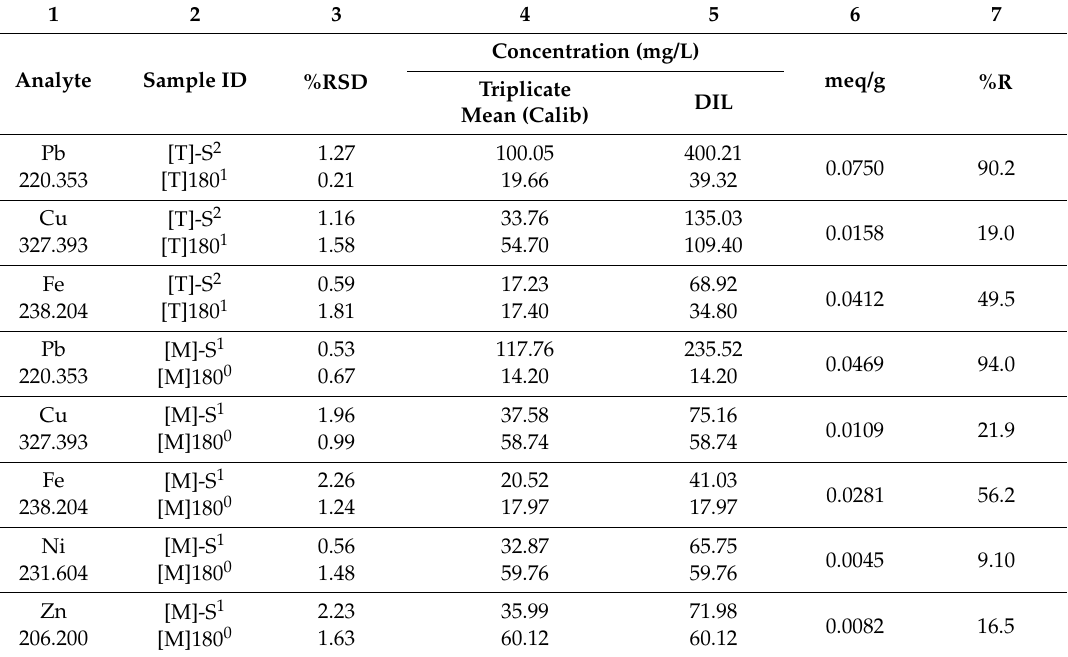
Table 3. ICP-AES HMI results of the triple- and multi-component systems. Table 3. ICP ‐ AES HMI results of the triple ‐ and multi ‐ component systems.